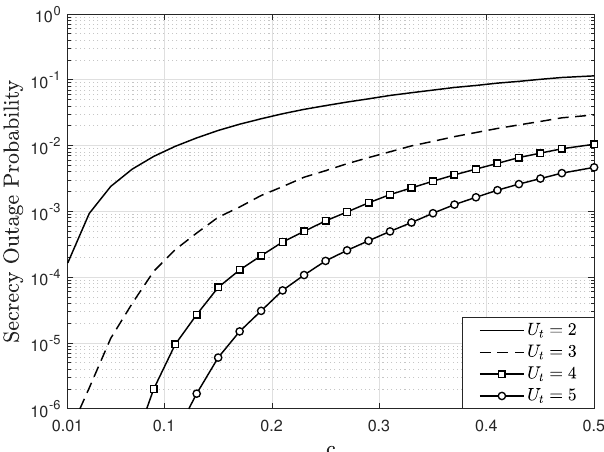
Figure 10. SOP as a function of c , parameterized by U t , considering M = 4, A = 3, A E = 2, U = 2, E b / N 0 = 15 dB, e = 0.1, and R = 1 bps in a Rician fading channel with K = 2.